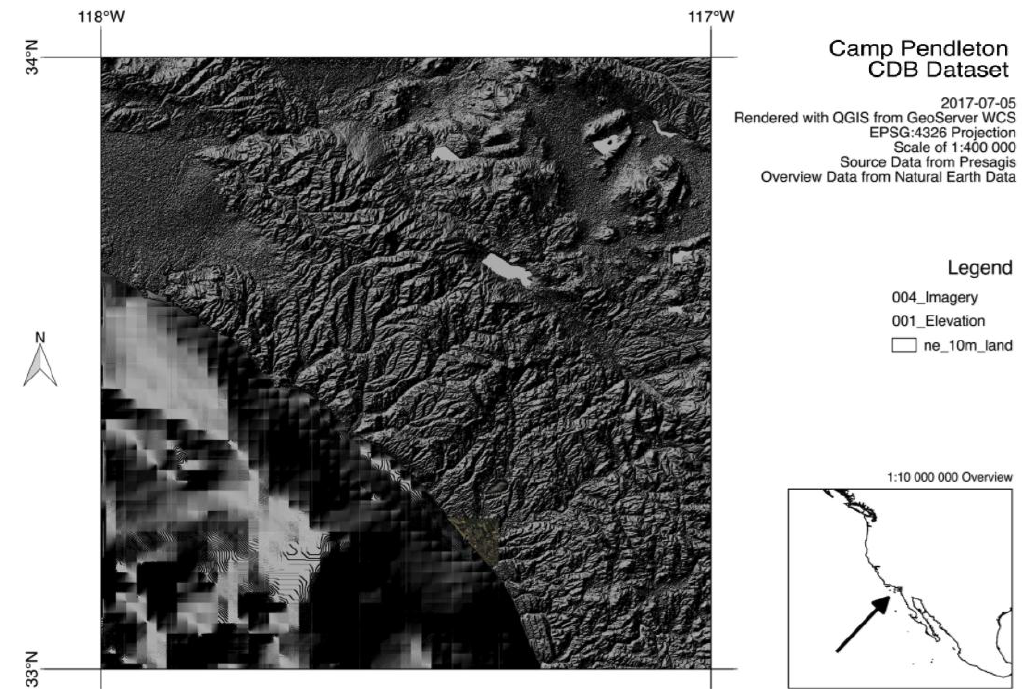
Figure 10. OGC CDB WCS prototype which offers multi-dimensional coverage data access.